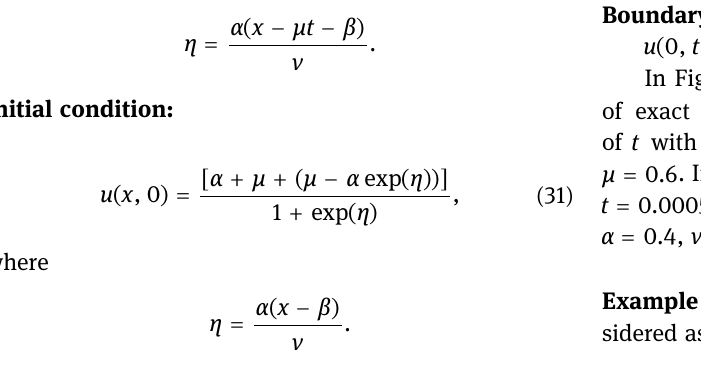
Table 8: Comparability of error norms with [ 12 ] , for = t Δ 0.01 , at = t 0.05 for diverse values of c , μ , and ν